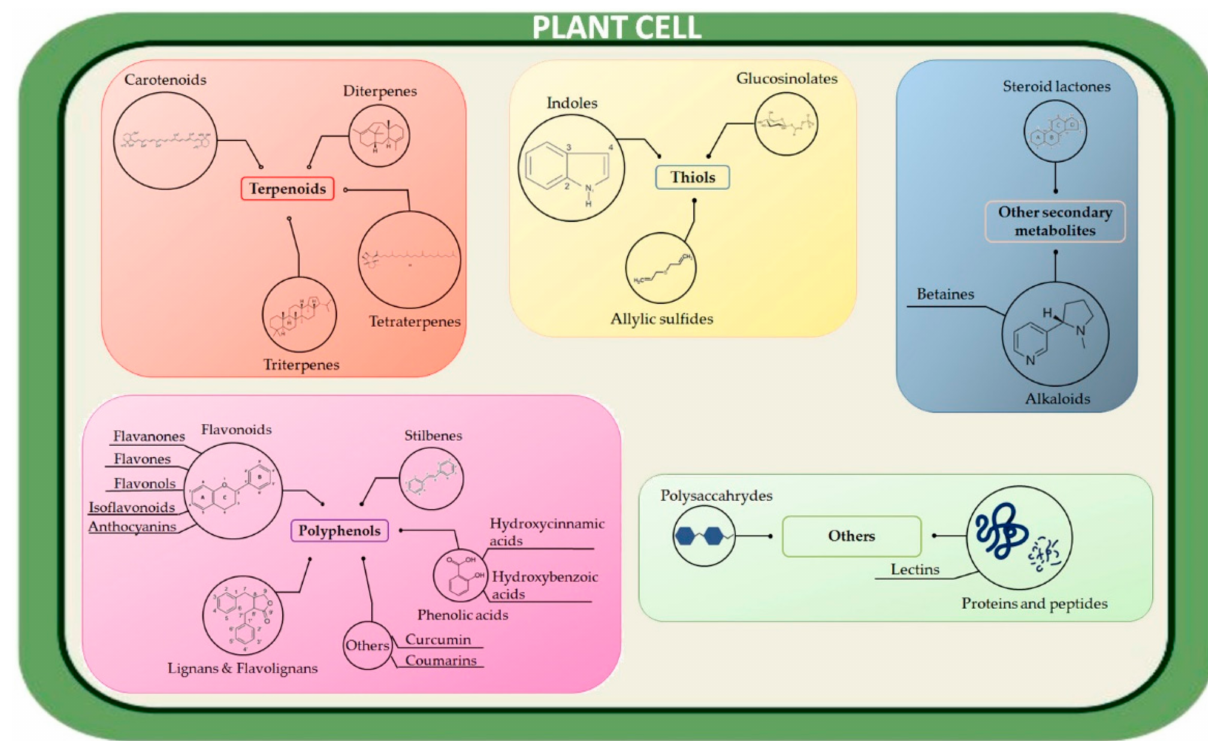
Figure 2. Phytochemicals investigated against